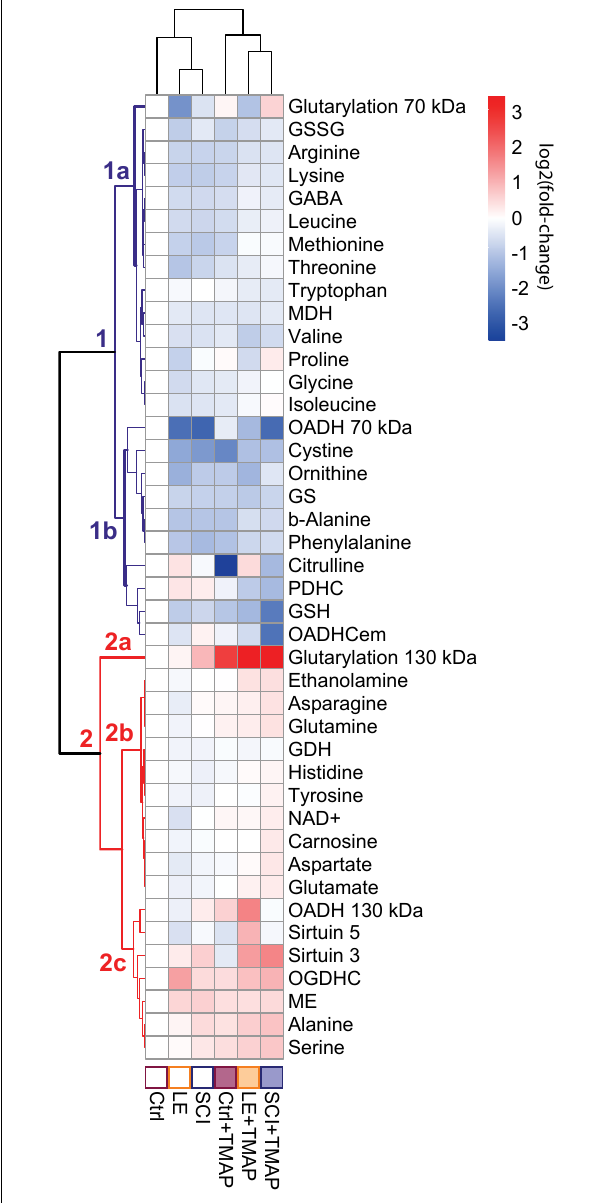
FIGURE 3 | Clusters of metabolic changes induced by the OADH-directed inhibitor TMAP in the cerebral cortices of the control (Ctrl), sham-operated (LE) and SCI rats. Metabolic changes in the cerebral cortex are presented as log 2 (fold-change), where a fold-change is a ratio of the mean metabolite level in the treated group to the corresponding mean level in the control group. These normalized values are shown in the heatmap according to the color code of the scale bar. The animal groups are indicated at the bottom of the heatmap and assigned the color code used in all the figures presenting the data on these groups. Metabolites (at the right side of the heatmap) and experimental groups (at the bottom of the heatmap) are clustered using ward.D method from pheatmap package in RStudio. The main metabolic clusters are numbered 1 and 2, each having the subclusters designated by the letters. The cluster 1 with decreased levels of metabolites is assigned the blue color, while the cluster 2 with increased levels of metabolites is shown in red. Number of animals in each group: Ctrl, n = 7; LE, n = 5; SCI, n = 5; Ctrl + TMAP, n = 5; LE + TMAP, n = 5; SCI + TMAP, n =